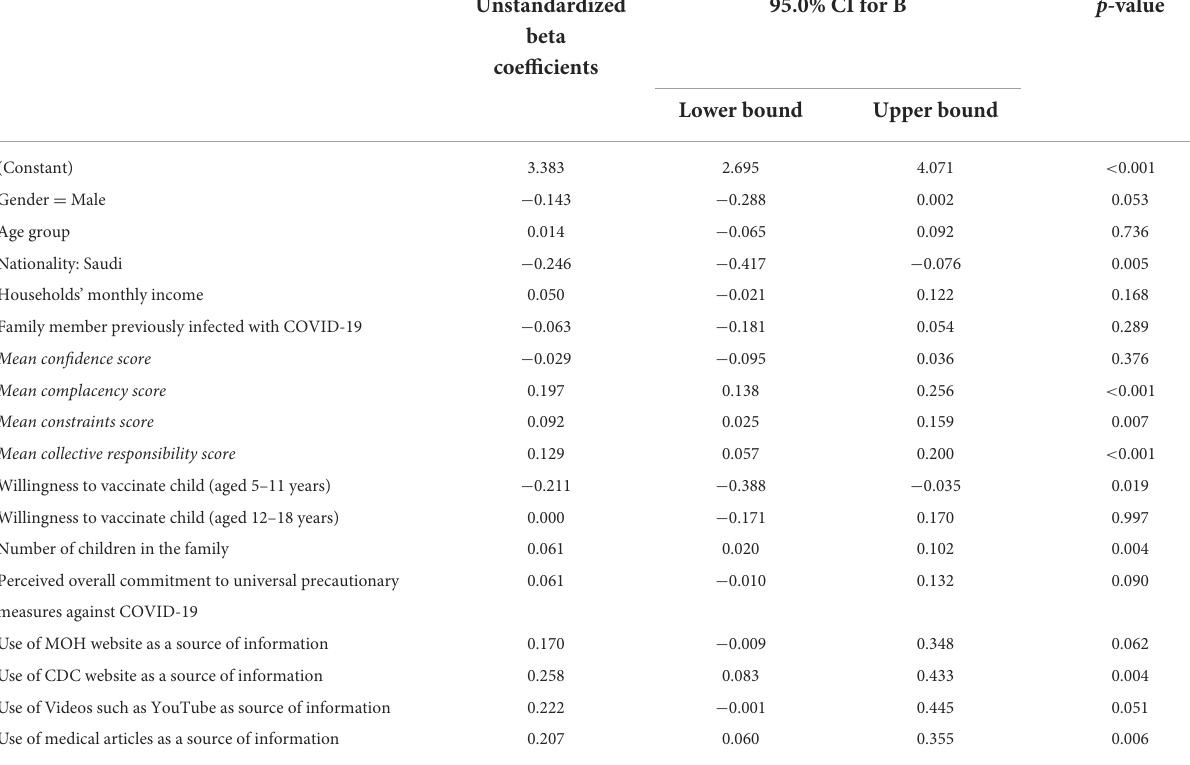
TABLE 4 Multivariate linear regression analysis of parents’ calculation as scored by the 5C